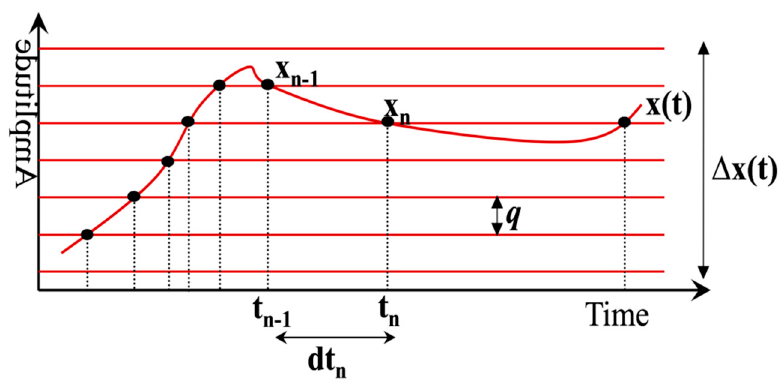
Figure 5. The event-driven sampling (EDS) process.